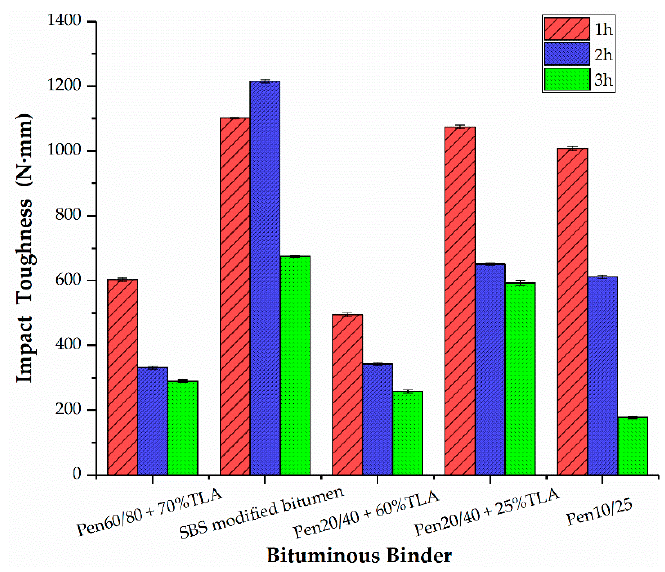
Figure 4. E ff ect of bituminous binder on the impact toughness Figure 4. Effect of bituminous binder on the impact toughness values.